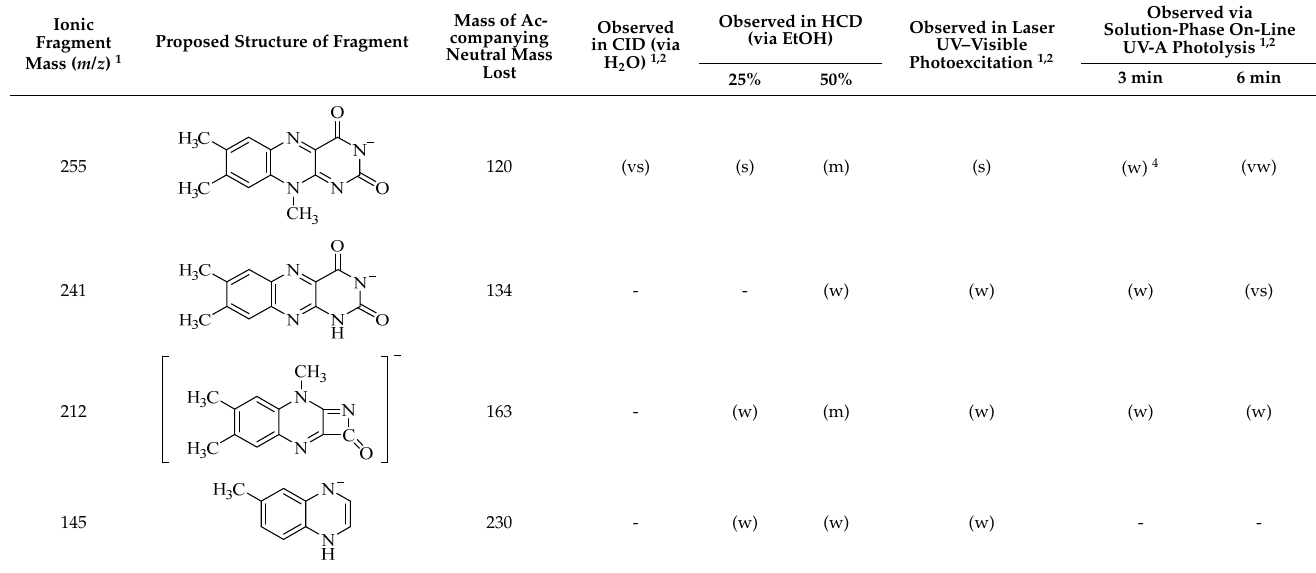
Table 1. Summary of the major ionic fragments of [RF − H] − ( m / z 375) observed upon collisional dissociation (CID), higher-collisional dissociation (HCD), gas-phase UV–visible laser photoexcitation, and solution-phase on-line UVA (365 nm) photolysis.